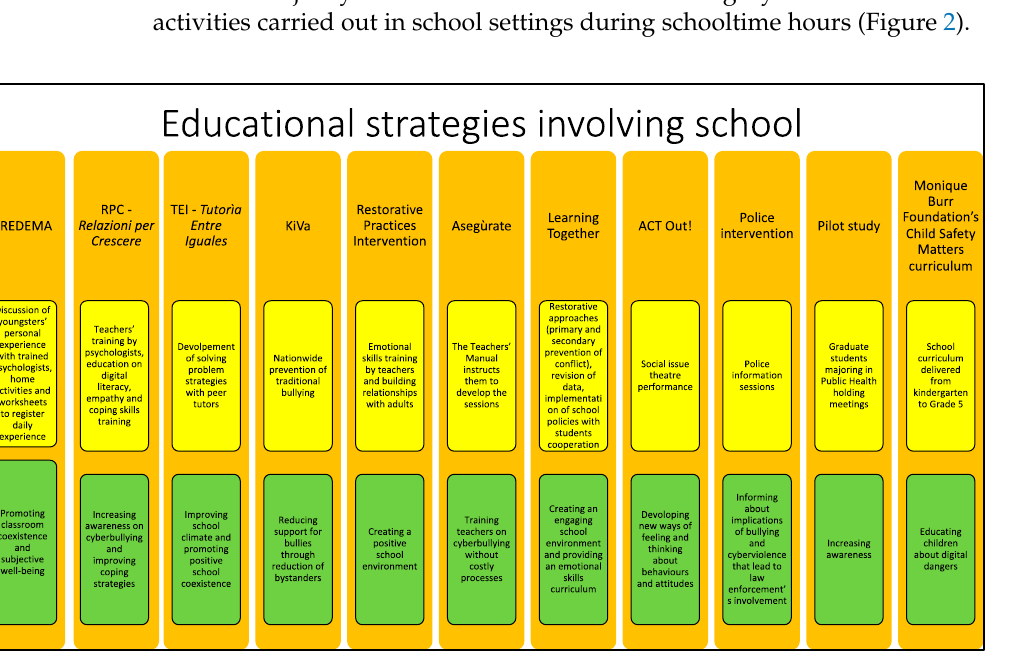
Figure 2. This figure summarizes descriptions and objectives of the educational strategies involving school that will be presented below. The name of the strategy is reported in orange boxes. Yellow boxes contain different strategies’ descriptions, while objectives are stated in the green boxes.